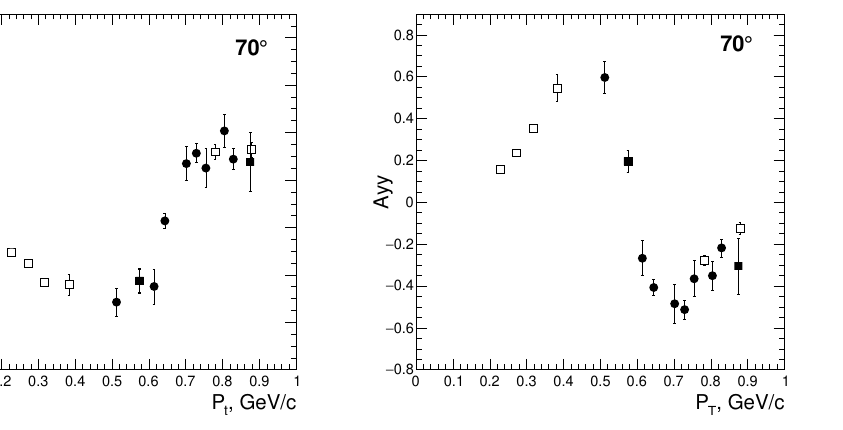
Figure 12. The energy dependence of the vector analyzing power A y at 70 ◦ in the c.m.s. The full circles are the preliminary results of the present experiment. The full squares are the data ob- tained at ITS at the Nuclotron in 2005 [14, 15]. Open symbols are the data [24, 25, 28, 36, 37] obtained in the previous experiments